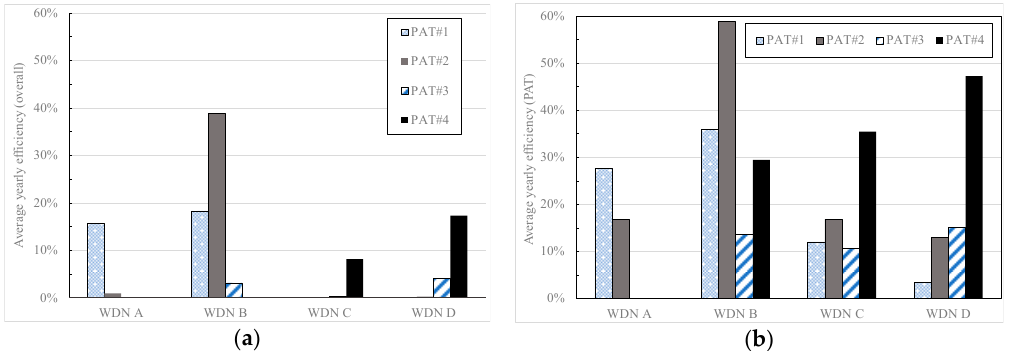
Figure 8. Average yearly conversion efficiency: ( a ) overall and ( b ) PAT.